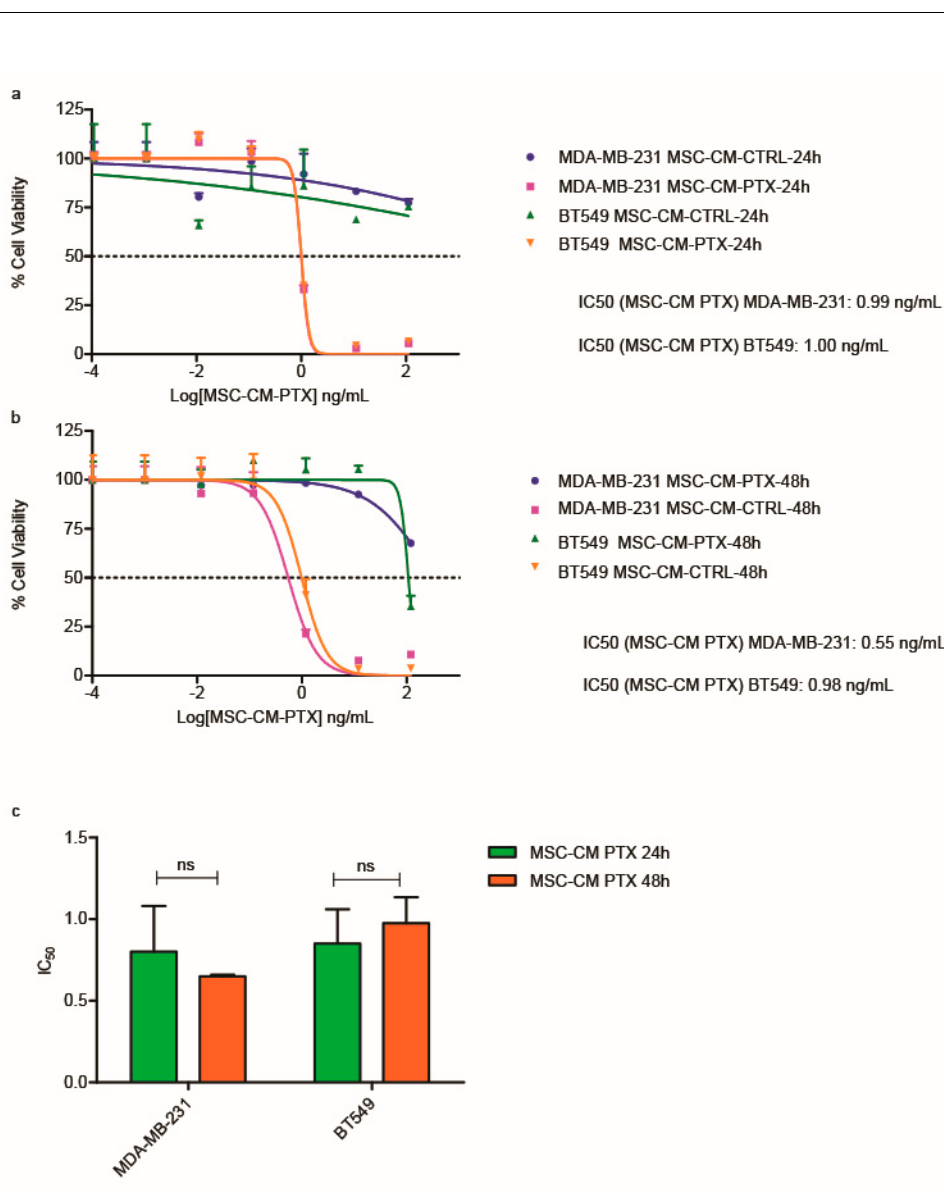
Figure 1. Viability inhibition in TNBC cell lines using MSC-CM PTX 24 h and 48 h at 144 h. Effects of MSC-CM PTX 24 h and 48 h at 144 h on the survival of TNBC cell lines ( a – c ). Dose–response curves in MDA-MB-231 and BT549 cells showing the effects of treatment with serial concentrations of MSC-CM PTX 24 h ( a ) and MSC-CM PTX 48 h ( b ). Dashed lines depict IC50 values. Both cell lines were tested in triplicate with both treatments and controls. A representative curve is shown for both experiments. The histogram reports the mean IC50 values for both cell lines treated with MSC-CM PTX 24 h and 48 h in triplicate ( c ). The data are expressed as means ± standard deviations (SDs). Differences between two data sets were determined by unpaired t -tests.